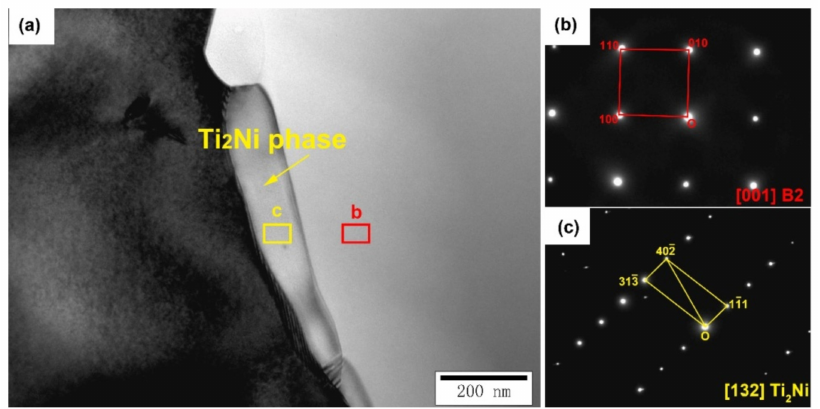
Figure 7. ( a ) is TEM morphologyanalysis of the 0% compressive deformation sample, ( b ) is SAED of the B2 parent phase (red box in ( a )) and ( c ) is the Ti 2 Ni precipitatedphase (yellow box in ( a